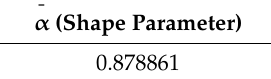
Table A9. MNIG Shape parameter α for Vector 3: Daqing, Marlim, SHCOMP, IBOV, NIFTY.